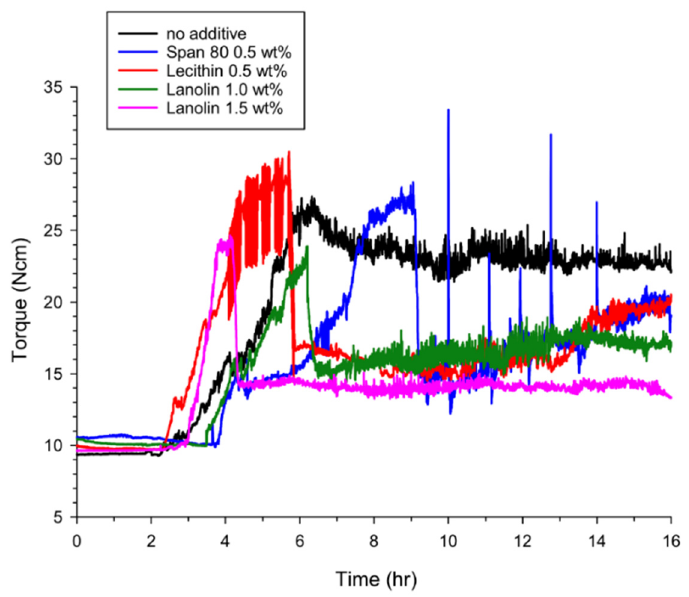
Figure 3. Rotational torques depending on time in the absence or presence of the AA additives at 50% water cut. 0.5 wt% Span 80, 0.5 wt% lecithin, 1.0 wt% lanolin and 1.5 wt% lanolin were added as the AAs.